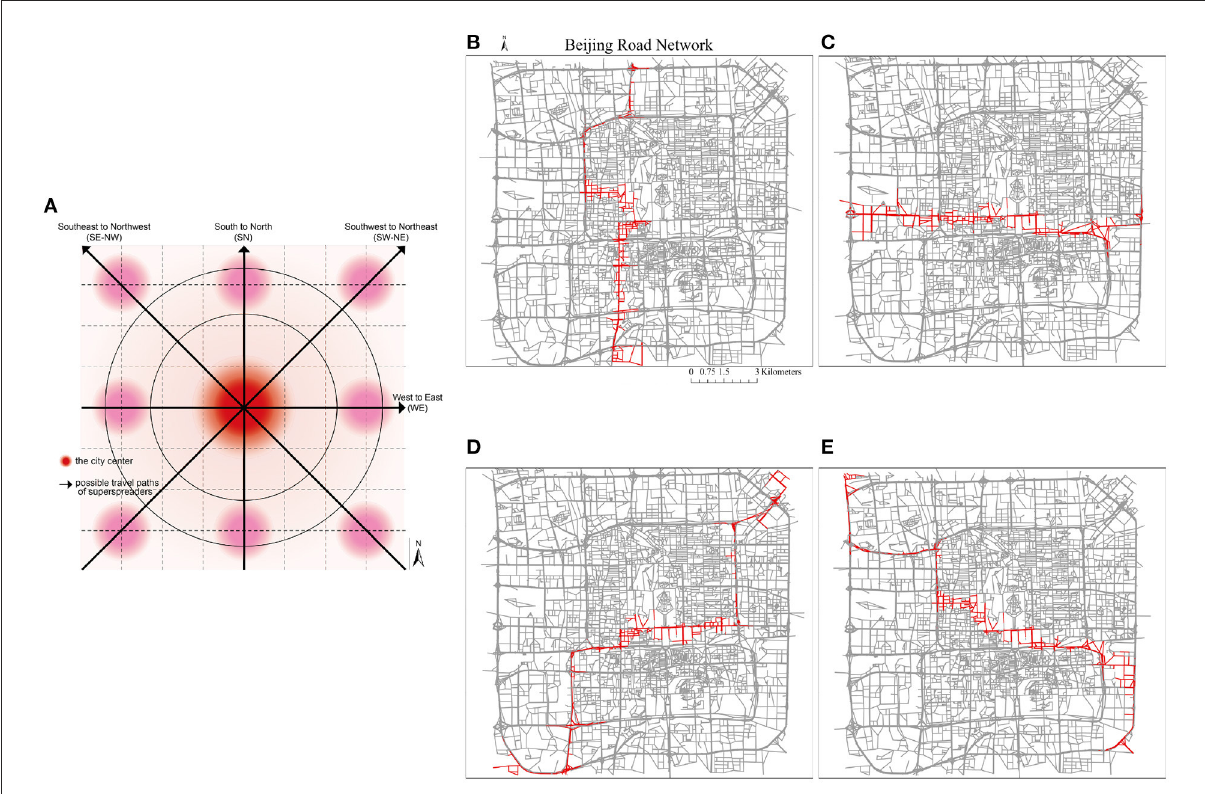
FIGURE15 The trajectories with different orientations of a superspreader. (A) An illustration of possible traveling paths of superspreaders. (B) South to North. (C) West to East. (D) South-west to North-east. (E) South-east to